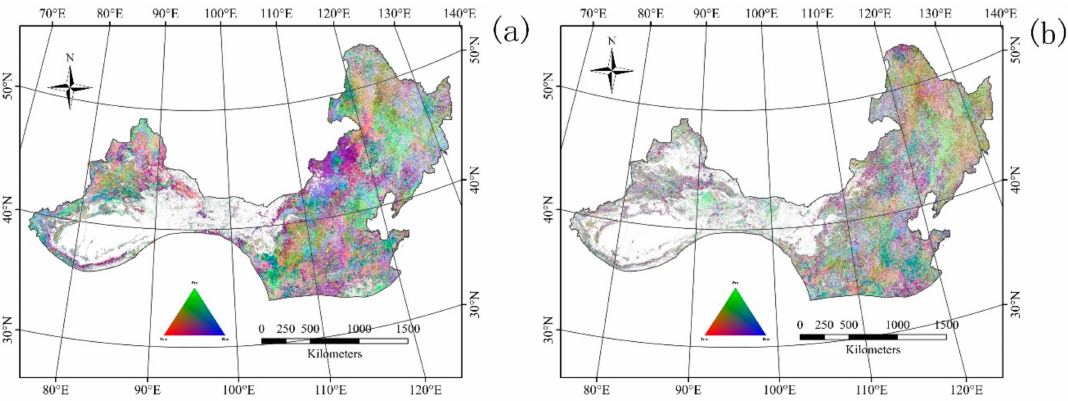
Figure 4. Relative contributions of climatic factors to the variation in the SOS ( a ) and EOS ( b ), respectively. Tem, temperature; Pre, precipitation; Rad, solar